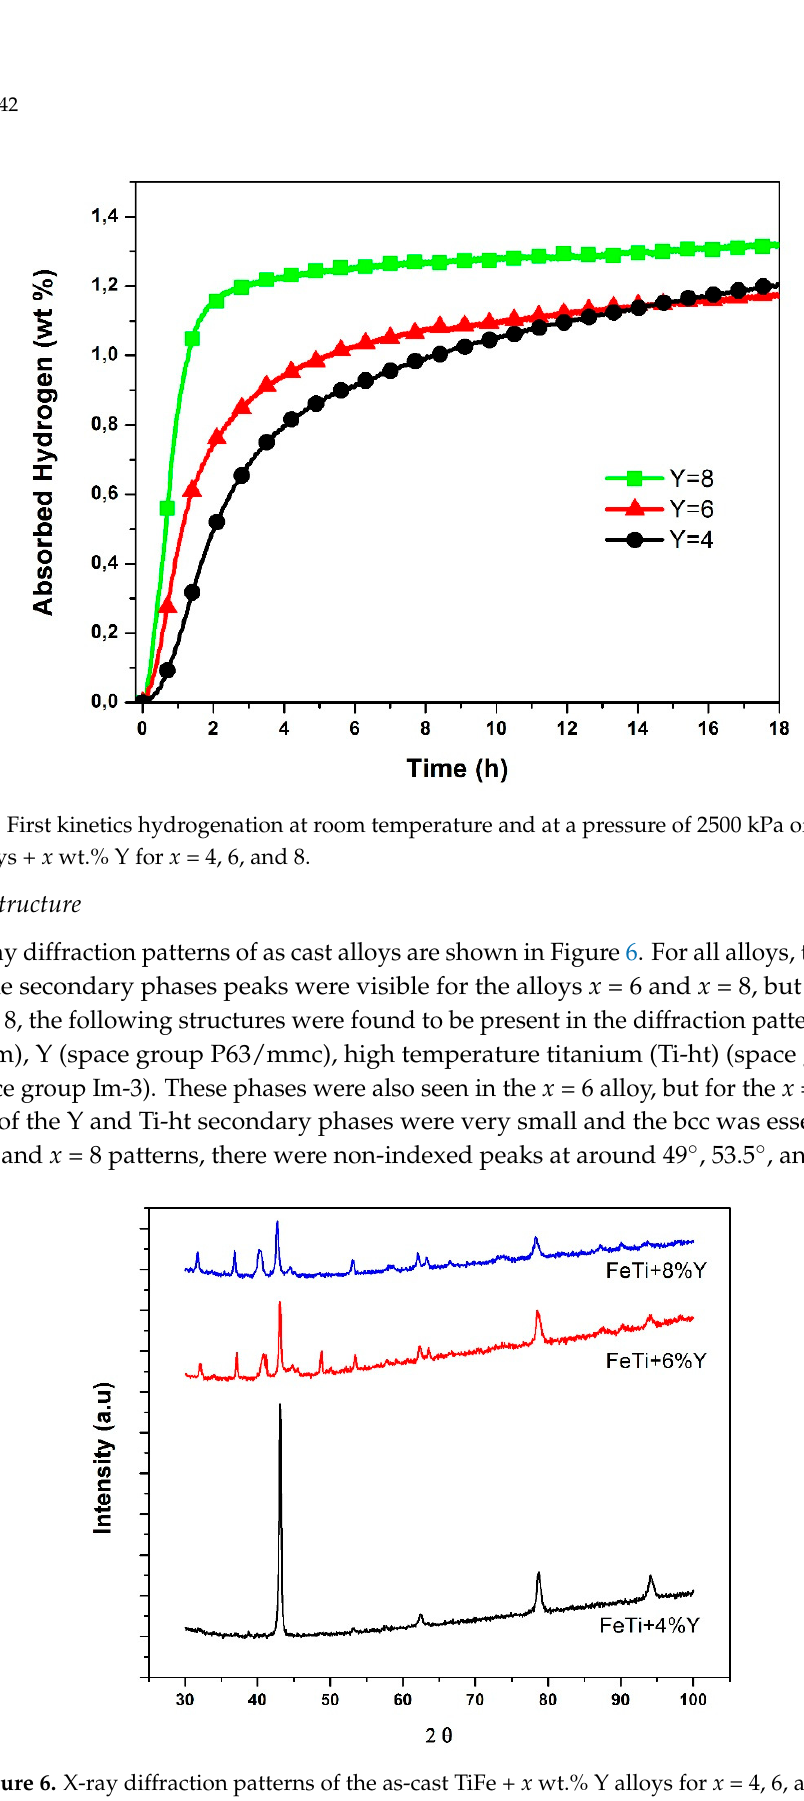
Figure 6. X-ray diffraction patterns of the as-cast TiFe + x wt.% Y alloys for x = 4, 6, and